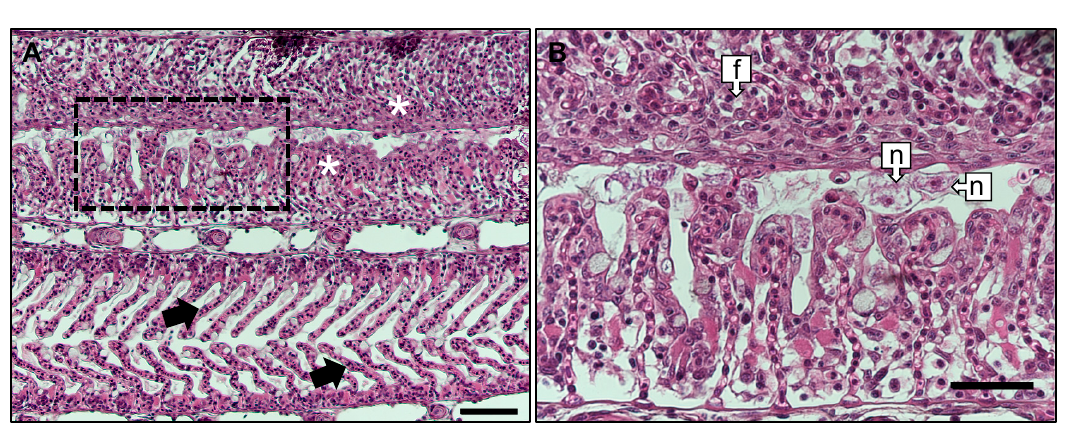
Figure 2. ( A )—Gill filaments from AGD affected fish, showing anatomically normal secondary lamellae in lower filaments (black arrows), adjacent to a hyperplasic lesion induced by N. perurans (white asterisks), Bar = 100 µm. Inset border (dashed line box) corresponds to ( B ), at 40x magnification. ( B )—frame subset of ( A ) showing fusion of secondary lamellae (f), and N. perurans trophozoites (n) with nucleus and endosymbiont present (Bar = 100 µm).